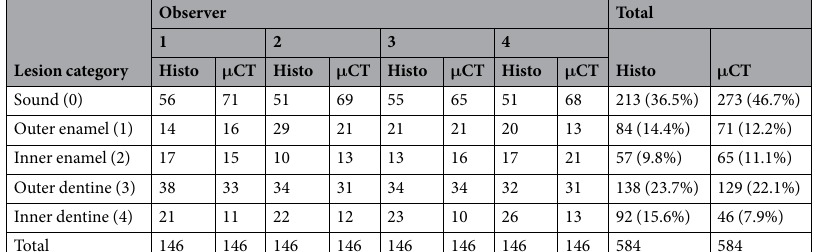
Table 1. Number of surfaces and their scores in 5 categories, obtained by scoring micro-CT ( μ CT) and histological images (Histo). Number of surfaces and their scores in 5 categories, obtained by viewing microCT and histological